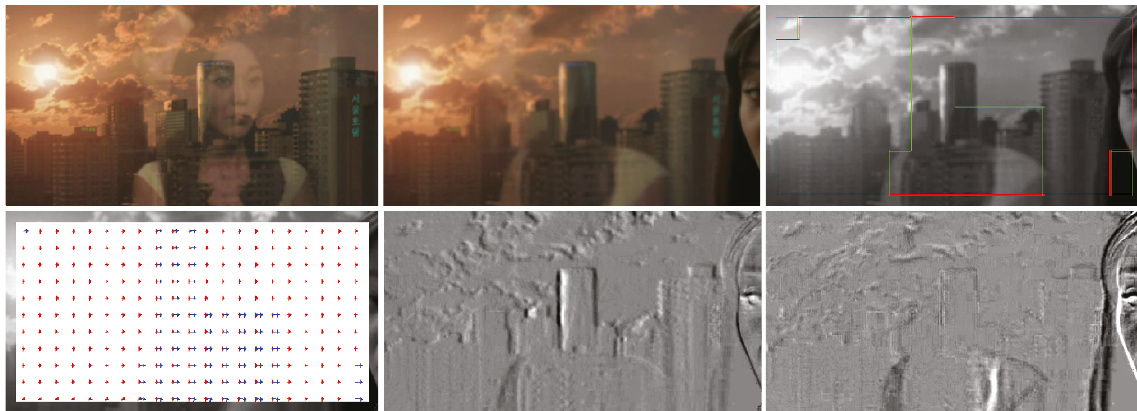
Figure 9: Example of a movie depicting two people reflected on an apartment window. From left to right and top to bottom: the first frame of the sequence; one of the three images corresponding to the reported results later in the sequence; the obtained segmentation into the transparent layer supports (the green polygonal line in the middle roughly encloses the reflected people); the velocity fields supplied by the estimated a ffi ne motion models; displaced frame di ff erences computed by compensating the motion of one of the two layers.